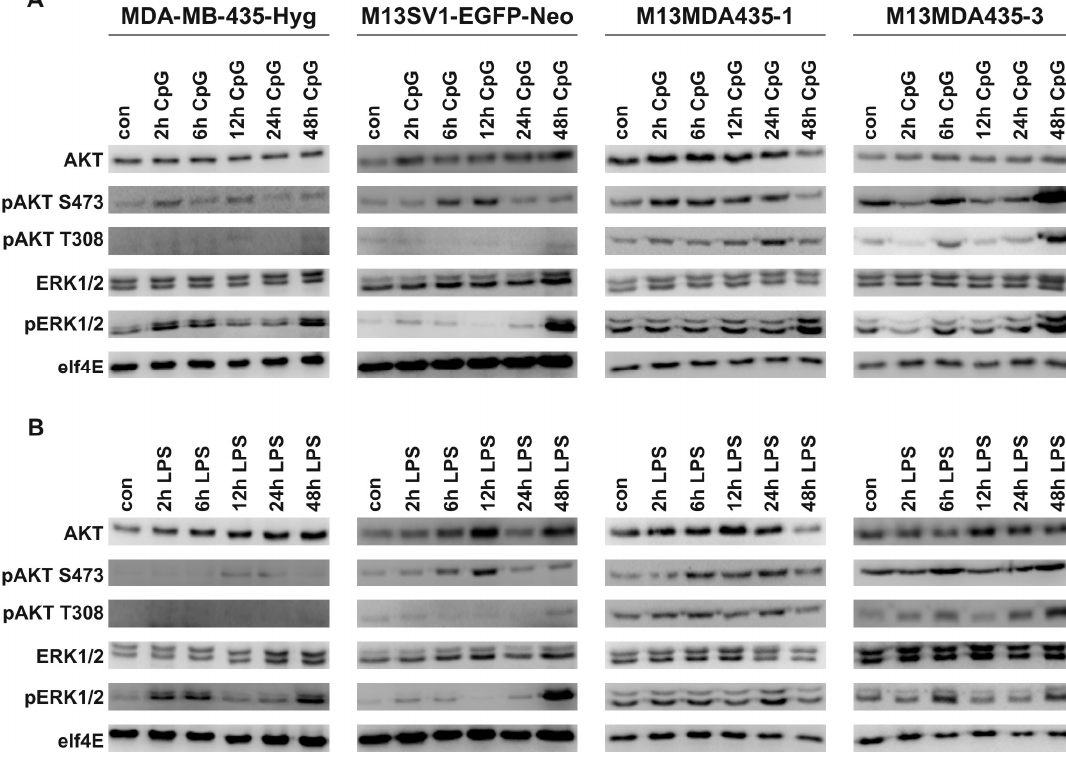
Figure 5. Activation of AKT and ERK1/2 in dependence of CpG and LPS stimulation. Cells were stimulated with either 100 ng/mL CpG ( A ) or 100 ng/mL LPS ( B ), respectively. Shown are representative data of at least three independent experiments.